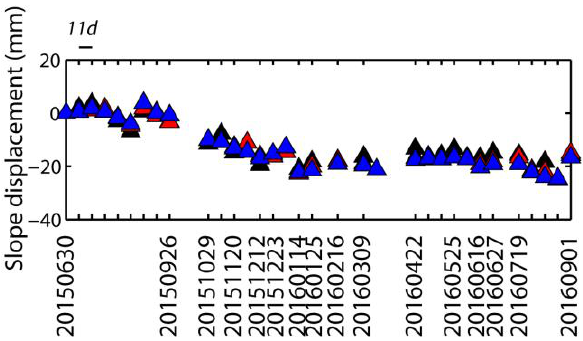
Figure 5. Slope displacement time series for point B shown in Figure 4(b). Black, red and blue triangles correspond to PS, SBAS and SqueeSAR methods